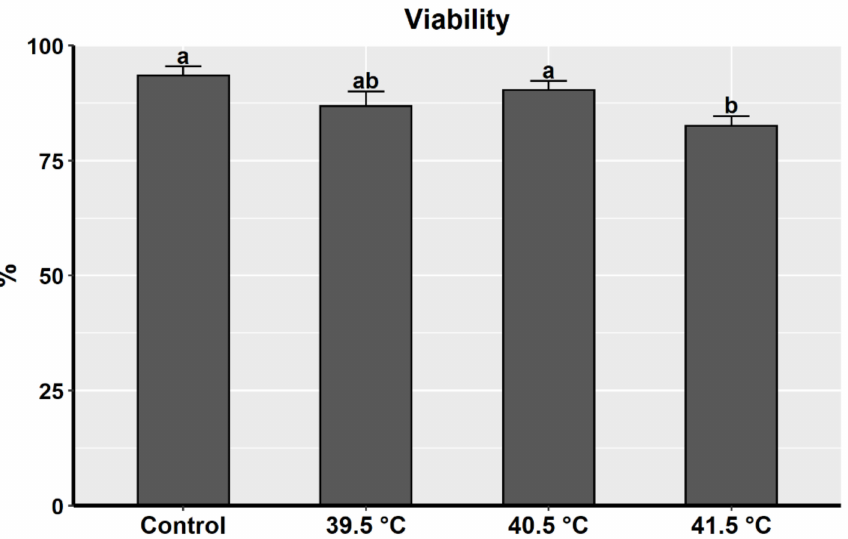
Figure 1. Viability of cultured granulosa cells under heat treatment (39.5, 40.5, and 41.5 ◦ C for the last 24 h of culture, 7 days) and control group (37.5 ◦